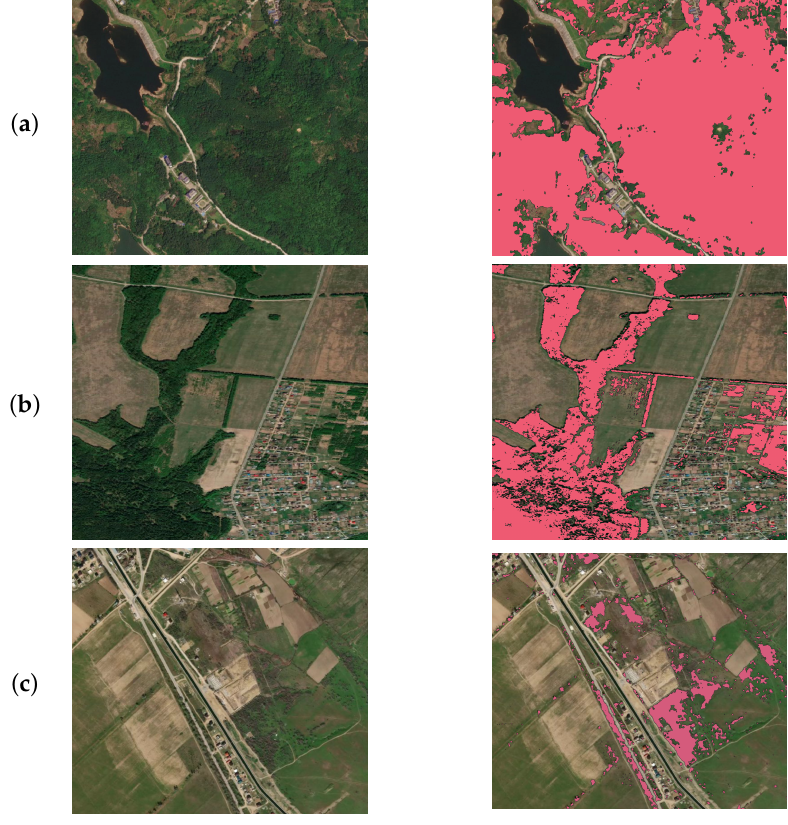
Figure 3. Raw images ( left ) and predictions ( right ) for different territories: ( a ) Baoting Li and Miao Autonomous County, Hainan, China, 18°29 (cid:48) 24.0 (cid:48)(cid:48) N 109°35 (cid:48) 24.0 (cid:48)(cid:48) E; ( b ) Zelenodolsky District, Republic of Tatarstan, Russia, 55°55 (cid:48) 48.0 (cid:48)(cid:48) N 48°44 (cid:48) 24.0 (cid:48)(cid:48) E; ( c ) Republic of Dagestan, Russia, 43°01 (cid:48) 09.1 (cid:48)(cid:48) N 47°19 (cid:48) 28.2 (cid:48)(cid:48)